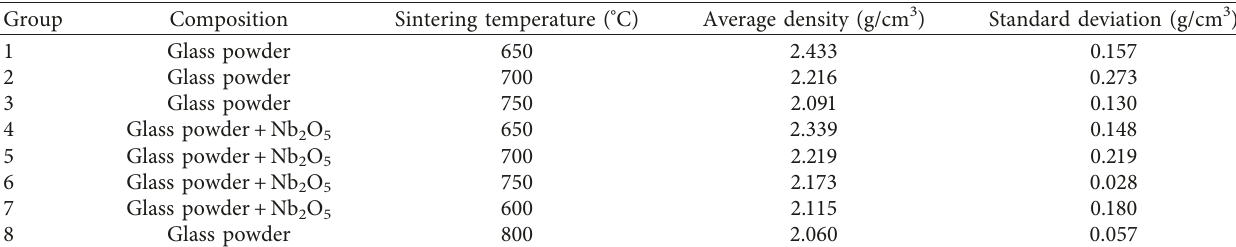
Figure 2: X-ray diffractogram of Groups 1–6. Table 2: Average density and standard deviation of the